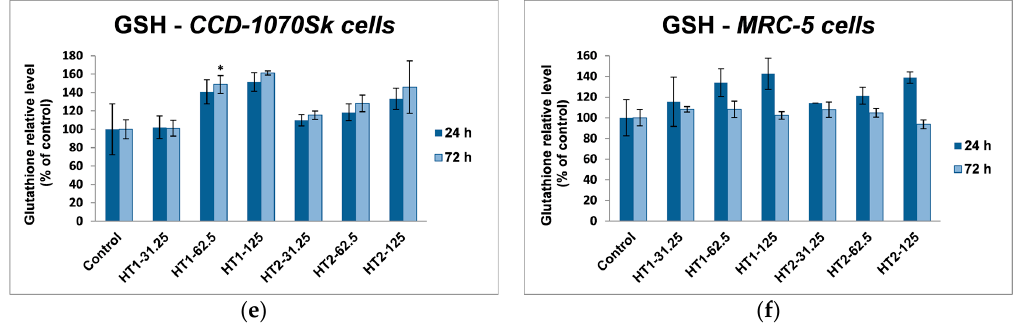
Figure 9. Glutathione-dependent enzymes’ activities and glutathione level in normal skin ( a , c , e ) and lung ( b , d , f ) fibroblasts exposed to different concentrations (31.25, 62.5 and 125 μ g/mL) of TiO 2 -1% Fe–N NPs co-precipitated at pH 8.5 (HT1) or 5.5 (HT2) for 24 and 72 h. Results are expressed as the mean ± standard deviation (SD) ( n = 3) and represented relative to the untreated cells (control). * p < 0.05, ** p < 0.01 and *** p < 0.001 compared to control.